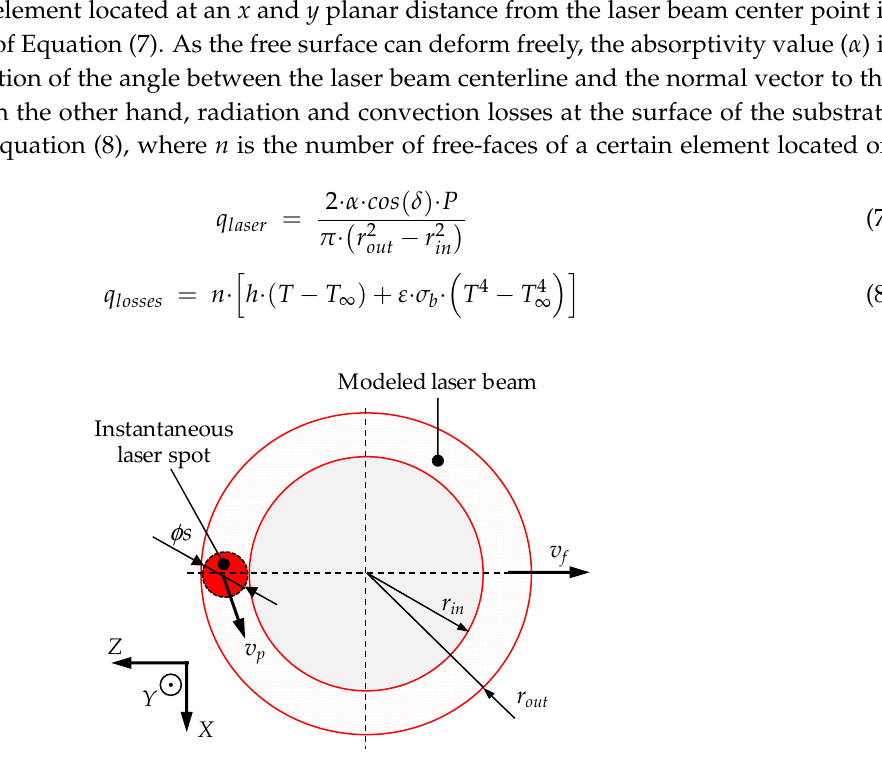
Figure 1. Instantaneous laser spot and modeled laser beam in wobble strategy.